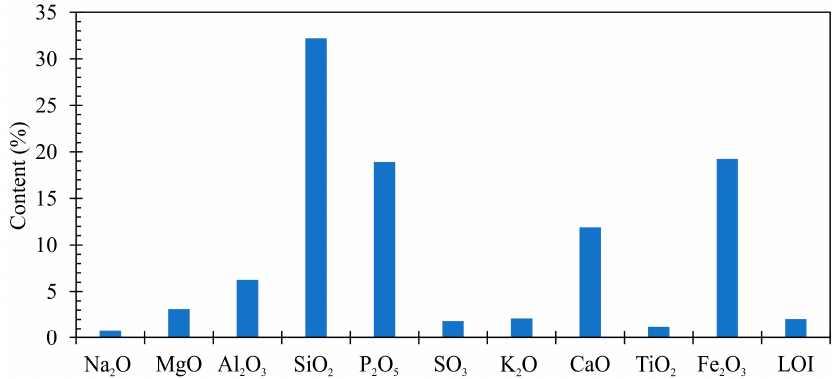
Figure 2. Chemical composition of fly ashes from thermally conversed municipal sewage sludge.